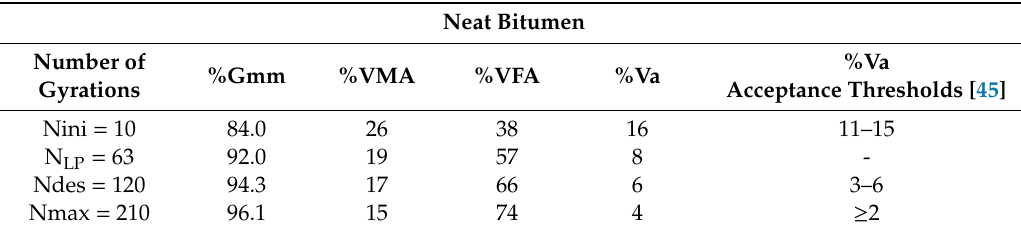
Table 4. Density variation and air voids content at different gyration levels for neat bitumen asphalt. Neat Bitumen